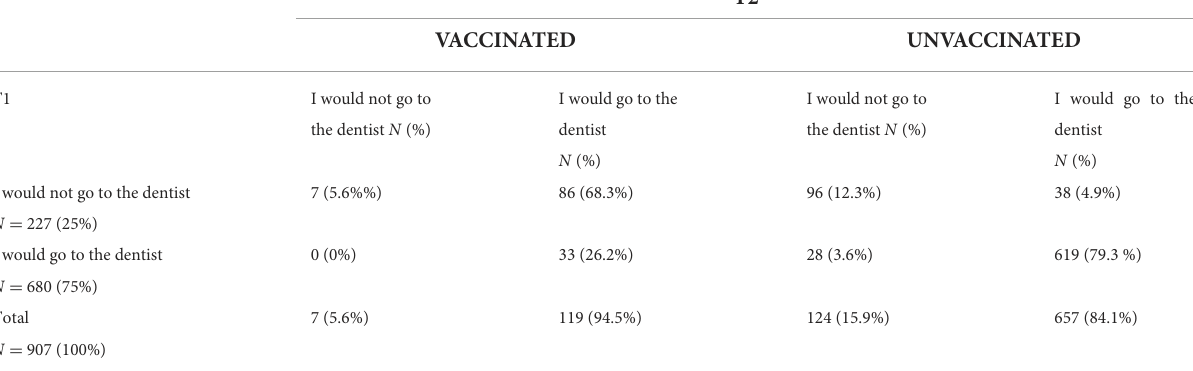
TABLE 5 Comparison of the frequency of dental avoidance at T1-T2 in vaccinated ( N = 126) and unvaccinated ( N = 781) at T2.